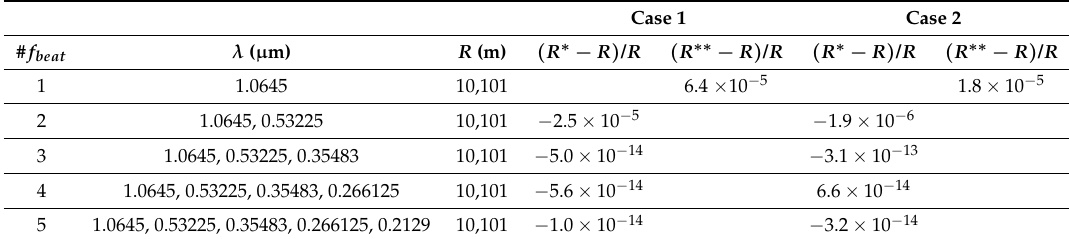
Table 1. Relative errors obtained from one ( ( R ∗∗ − R ) / R ) and multi-wavelength ( ( R ∗ − R ) / R ) approach in two different atmospheric conditions (Case 1 and Case 2 as reported in Table 2). The first column of the table reports the number of wavelengths used by the new method, while the second column reports their values.